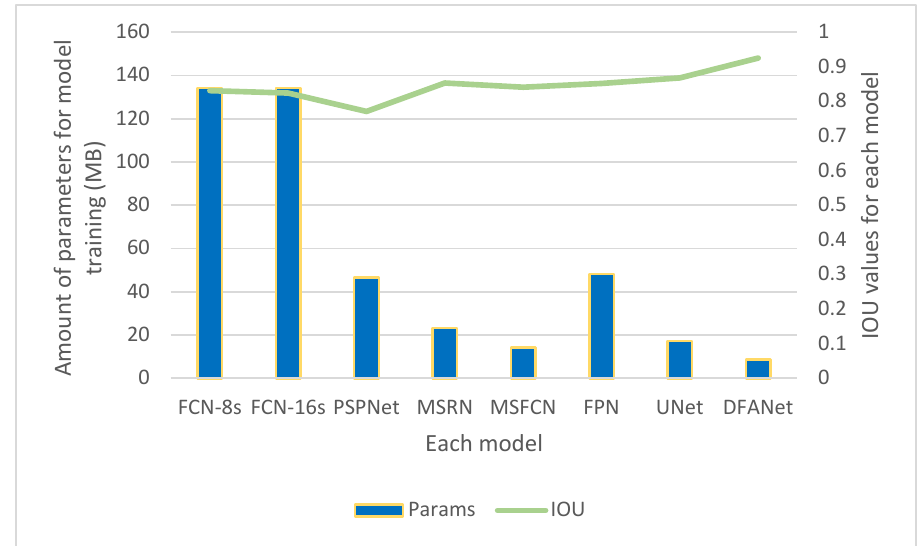
Figure 12. The IOU value and the amount of training parameters of the training results of different models.